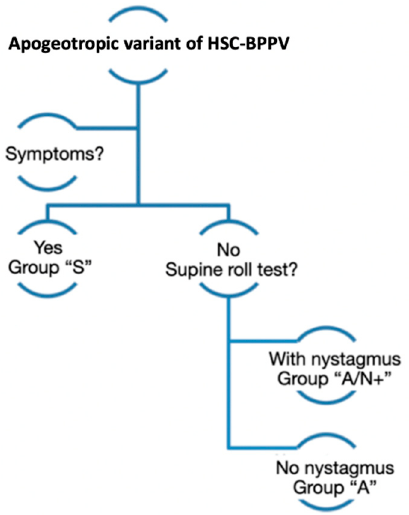
Figure 3. Variables studied when considering the efficacy of the maneuver. In follow-up consultation, patients diagnosed with the apogeotropic variant of BPPV-HSC were first classified in two groups according to the presence/absence of symptoms. Secondly, if patients presented symptoms, they were classified in “S” group (same clinical symptoms no examination). If this were not the case, the presence/absence of nystagmus was assessed following the supine roll test. Patients with nystagmus were classified as group “A/N+” (no symptoms but still nystagmus), while patients without it were classified as group “A” (no symptoms and no nystagmus).